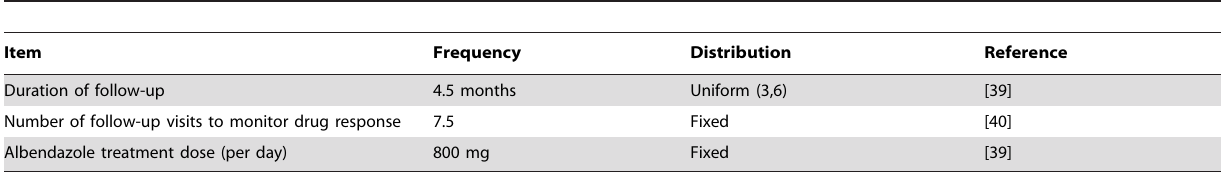
Table 2. Additional epidemiological parameters used to estimate the cost of medical treatment for cystic echinococcosis in A´lava,